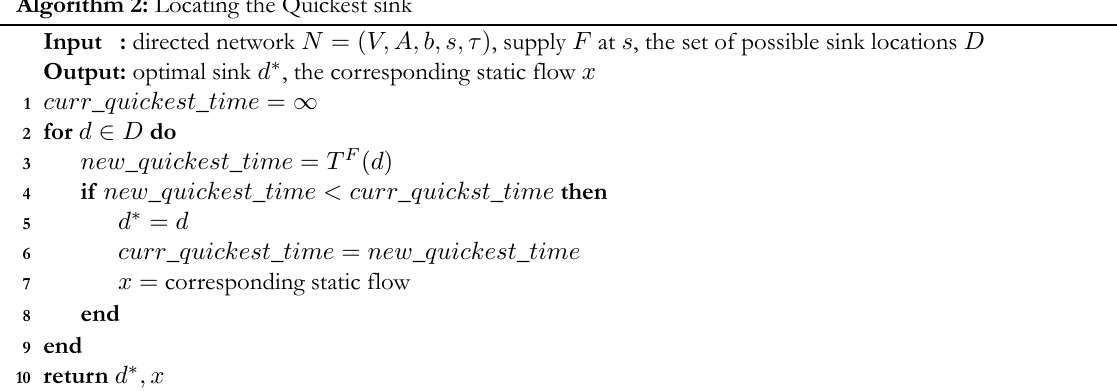
Algorithm 2: Locating the Quickest